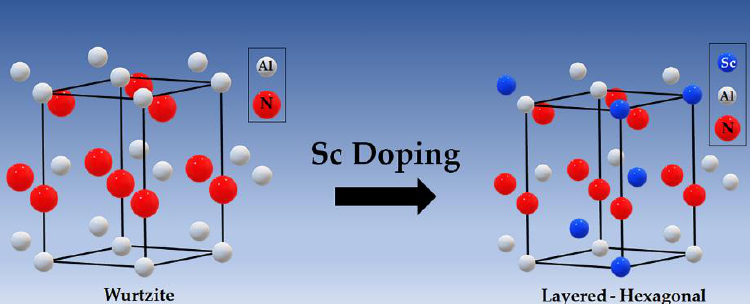
Figure 1. Crystal structure transition of AlN from wurtzite to layered-hexagonal with Sc doping to form Sc x Al 1 − x